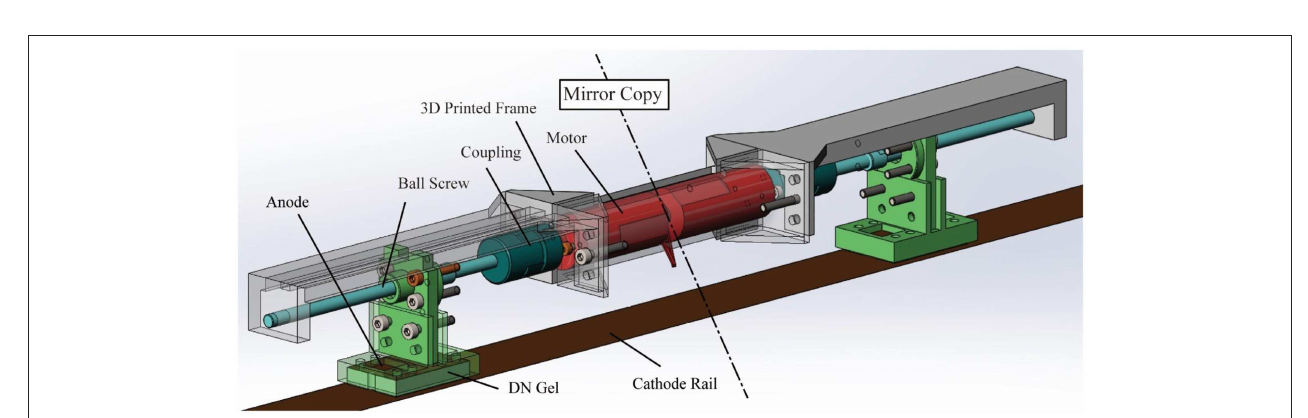
FIGURE 4 | The mechanism of the inchworm search robot.